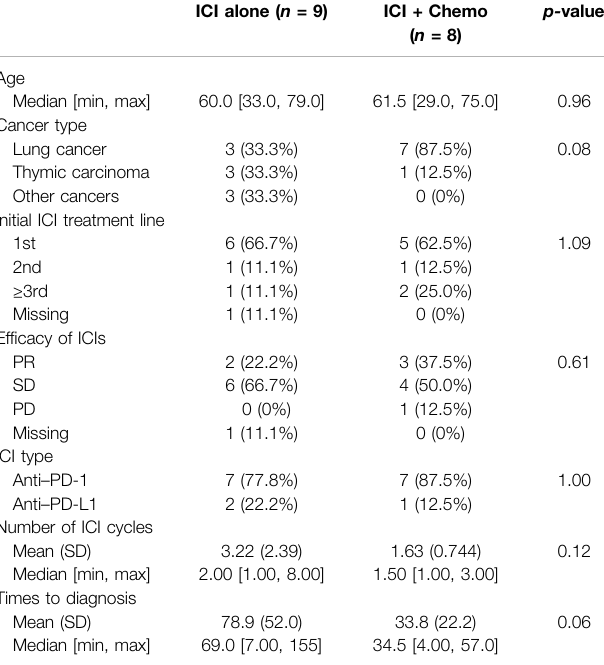
TABLE 2 | Comparison of treatment regimens in myocarditis